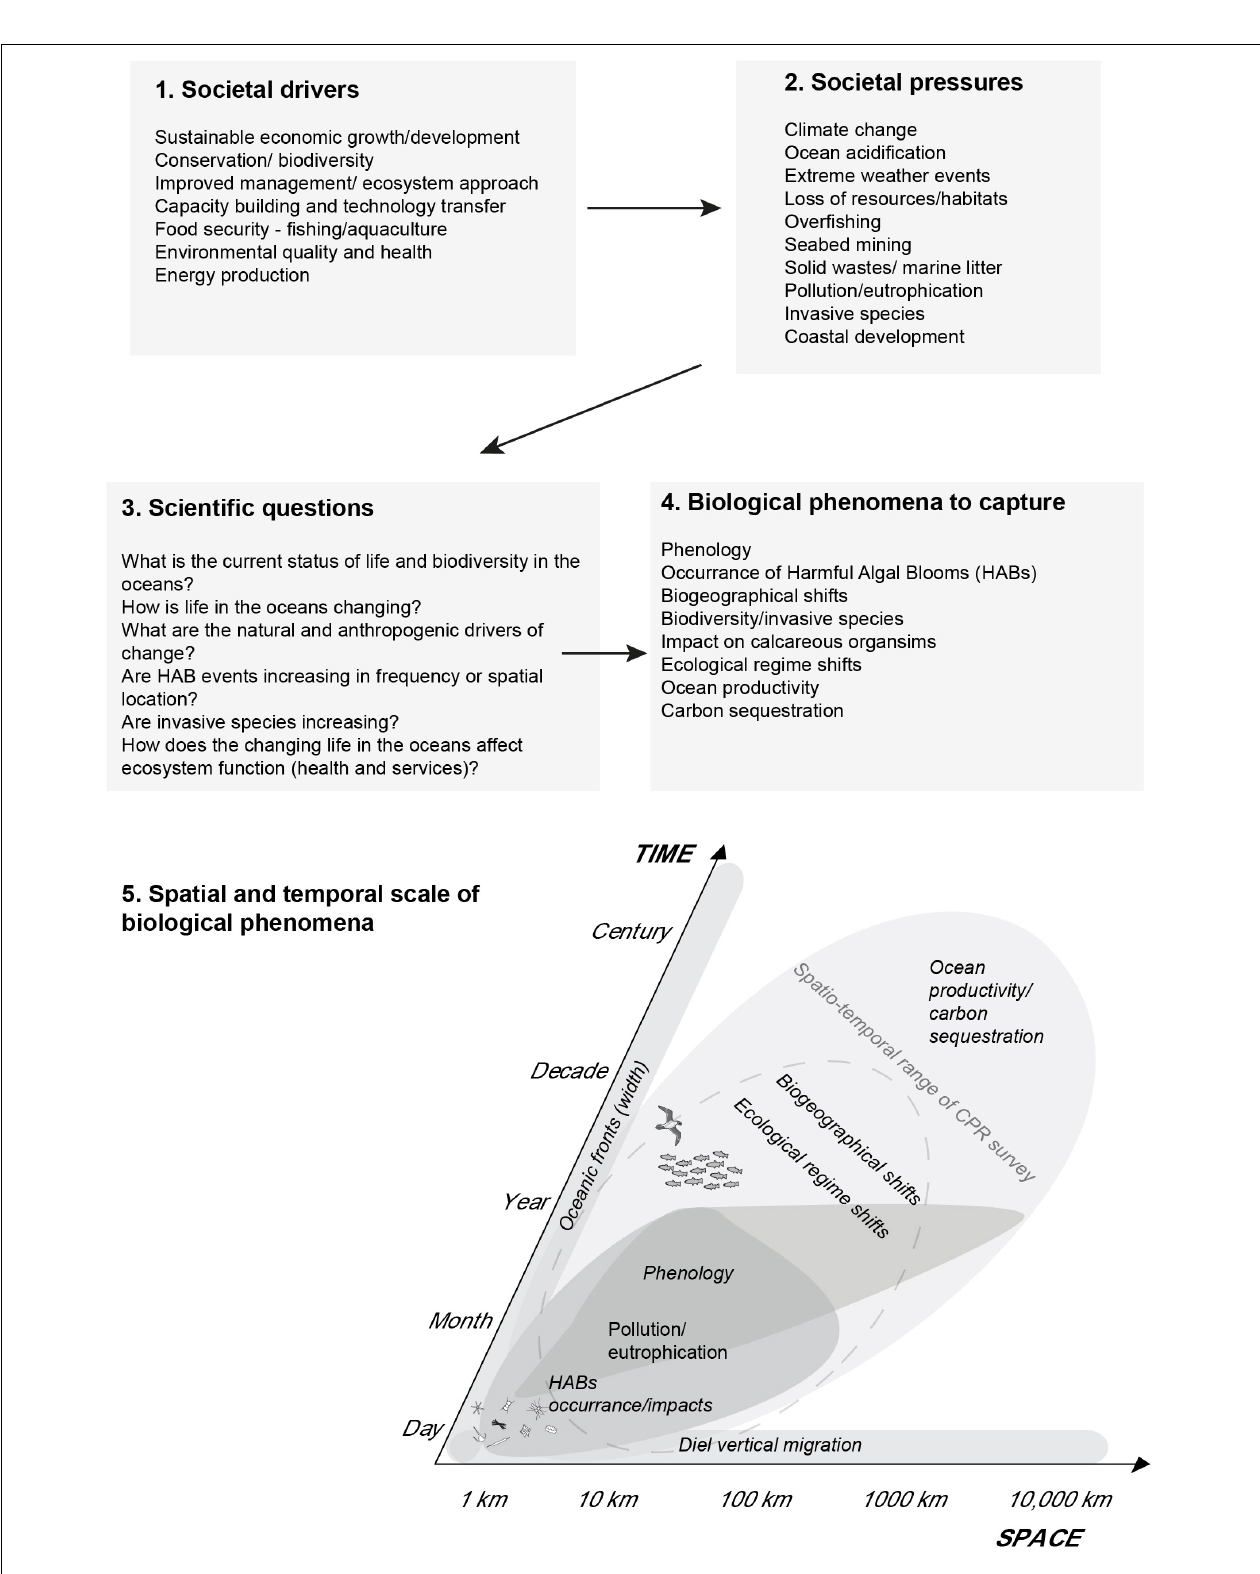
FIGURE 2 | Key societal drivers and pressures on the marine environment and the aspects of plankton dynamics used to capture their impacts on the oceans. The aspects of plankton dynamics addressed occur at multiple spatial and temporal scales and therefore require monitoring by a system, such as the CPR survey network, which operates at similar scales. Based on Edwards et al.